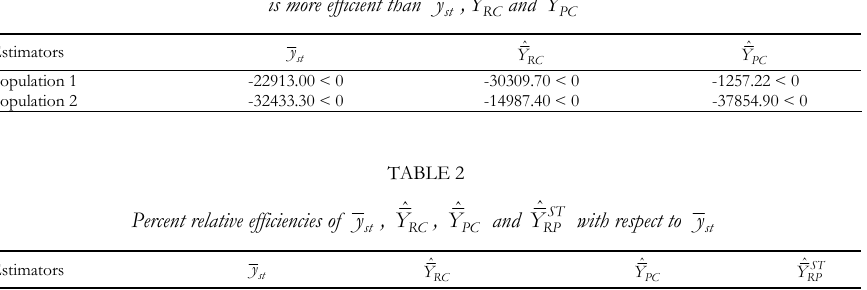
Empirical presentation of conditions (16), (17) and (18) under which the suggested estimator